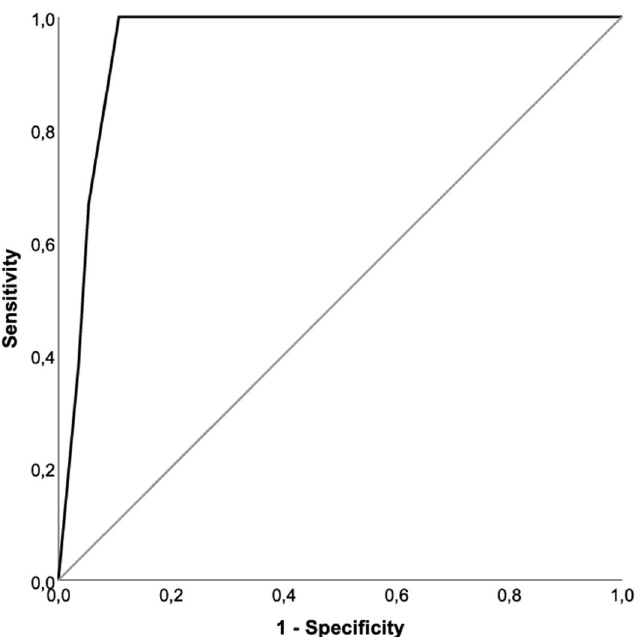
Figure 6. ROC curve of the adjusted PTA score. ROC analysis of the adjusted PTA score revealed a statistical cut-off value of adjPTA = 2.5 (sensitivity = 1.0, specificity = 0.89, p < 0.001) to identify patients suffering from PTA (black line: ROC curve; grey line: diagonal association